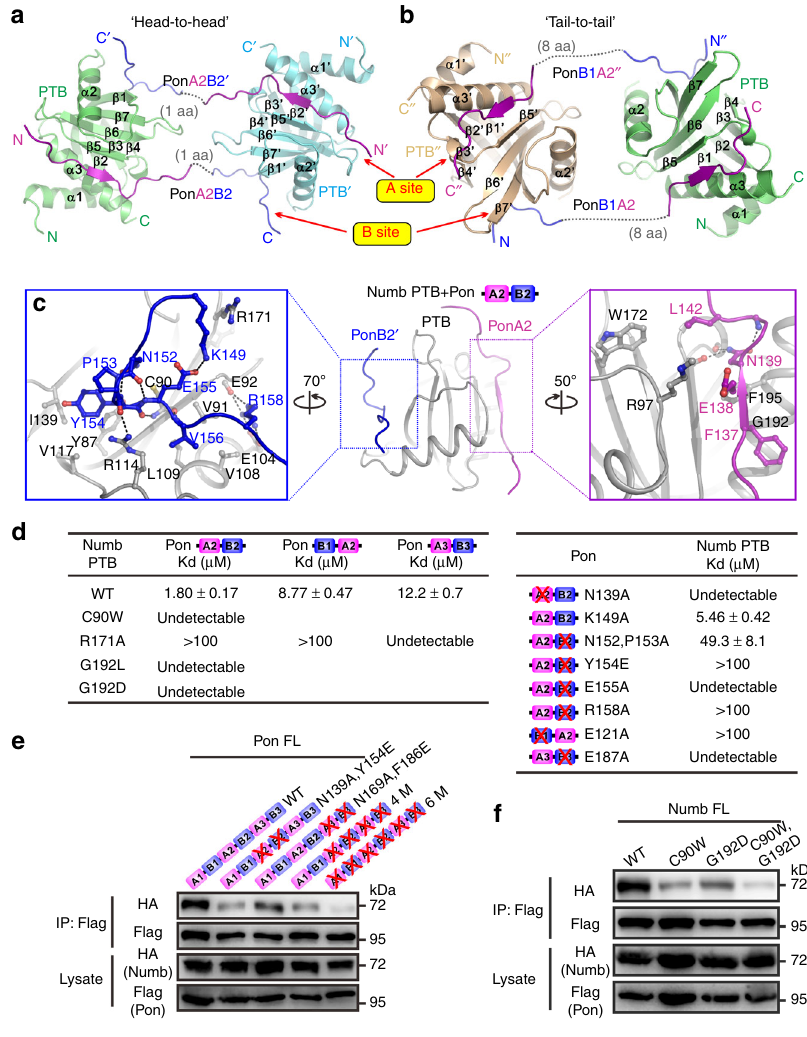
Fig. 2 The crystal structures of Numb PTB in complex with Pon A2B2 or Pon B1A2. a , b Ribbon representations of Numb PTB/Pon A2B2 ( a ) and Numb PTB/Pon B1A2 ( b ) complexes as viewed from the top. The A and B sites are indicated. c The interaction details between the representative Numb PTB (gray) and Pon A2B2 (purple and light yellow) complex. Charge-charge and hydrogen-bonding interactions are highlighted by dashed lines in black. d Summary of the quantitative binding constants between various Numb PTB and Pon fragments derived from the ITC-based titration assays shown in Supplementary Fig. 2b – d. e In HEK293T cells, N139A,Y154E Pon , N169A,F186E Pon , 4M Pon , or 6M Pon mutation abolished or signi fi cantly impaired the interaction between Numb and Pon. f Numb C90W , Numb G192D , and Numb C90W,G192D could not coimmunoprecipitate with Pon WT . Uncropped blots are shown in Supplementary Fig.